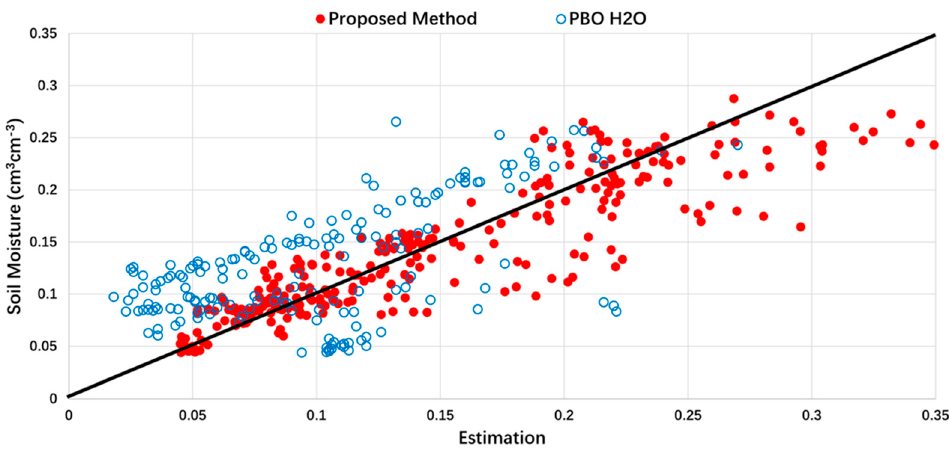
Figure 13. Scatter diagram of the estimated soil moisture by the proposed method and the PBO H2O project.